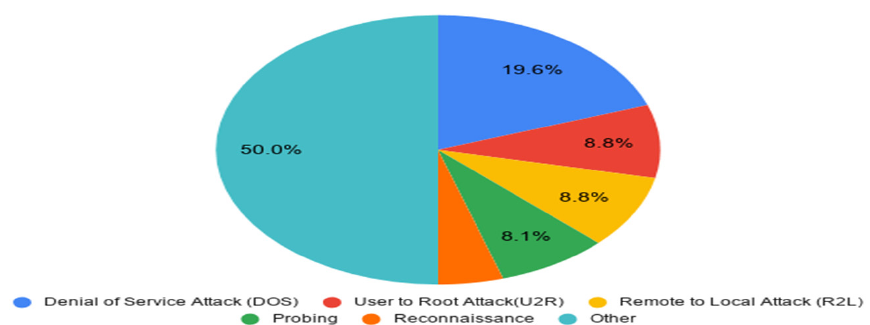
Figure 4. Percentage of IoT attacks considered in primary studies . Table 9. IoT attacks according to the layers.